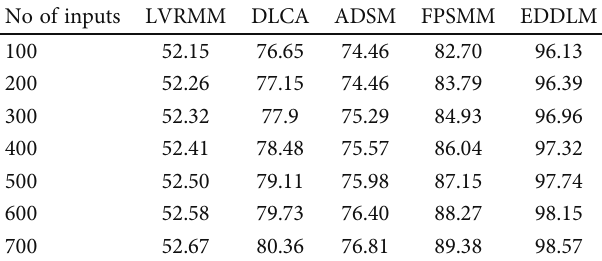
Table 4: Heat loss and cold bridges